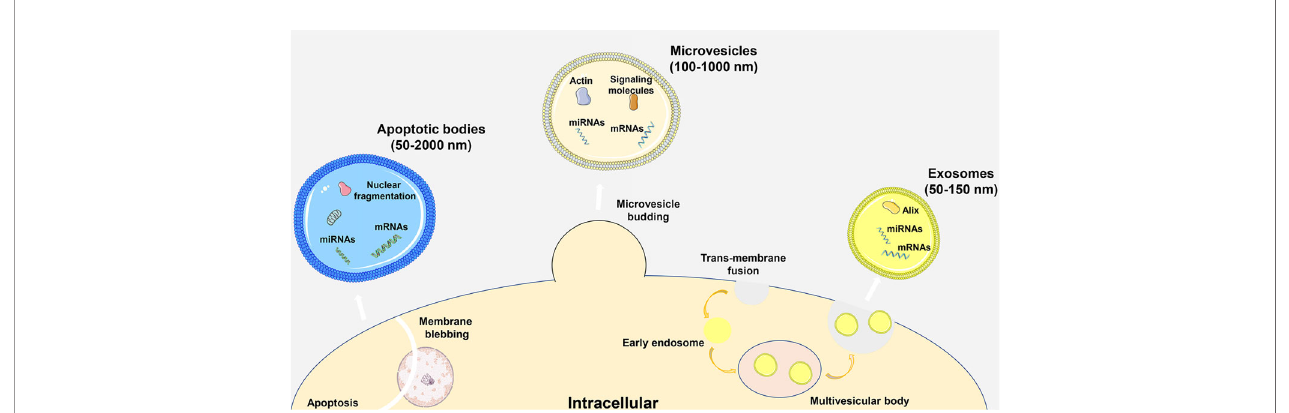
FIGURE 1 | Particle size, formation process and classi fi cation of